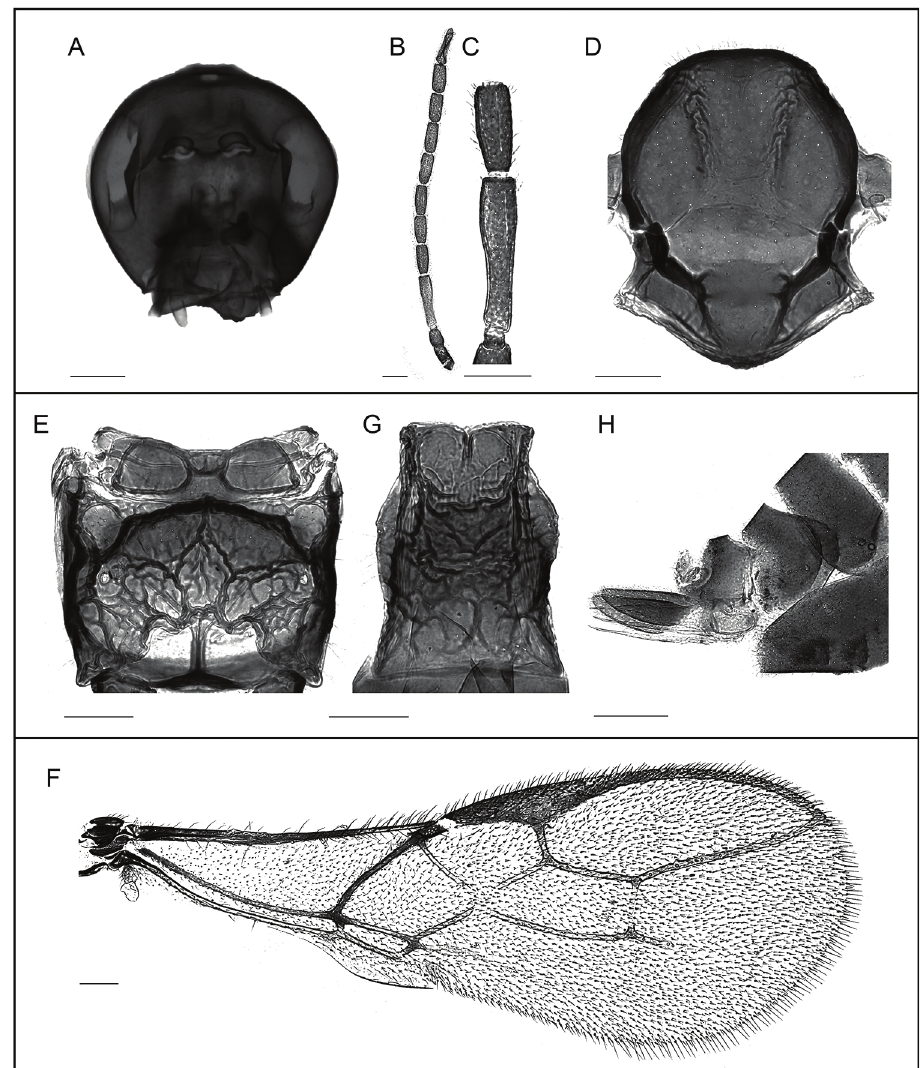
Figure 2. Ephedrus carinatus sp. nov. Tomanović A head B antenna C first and second flagellar segment D mesoscutum – dorsal aspect E propodeum – dorsal aspect F forewing G petiole – dorsal aspect H ovi- positor sheaths – lateral aspect. Scale bars: 100